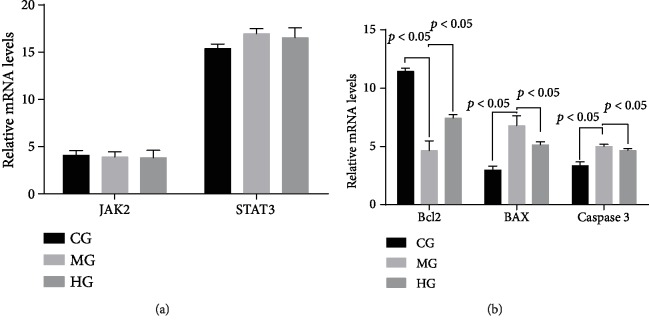
Relative mRNA levels of JAK2/STAT3 signaling and apoptotic molecules.